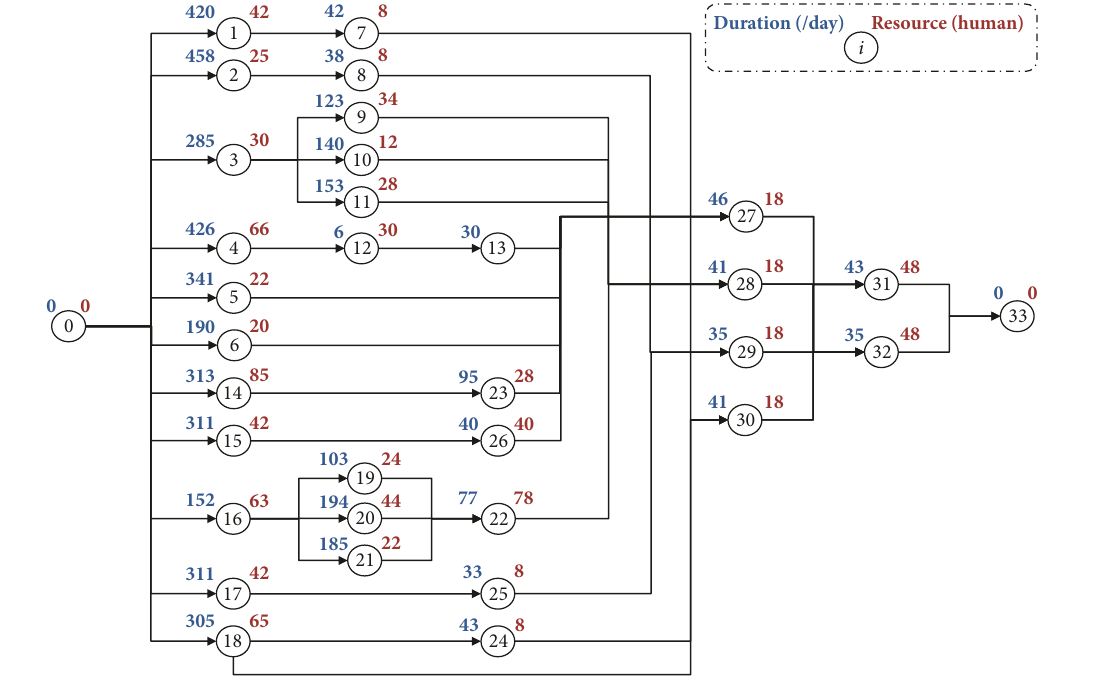
Figure 6: Network of construction project.